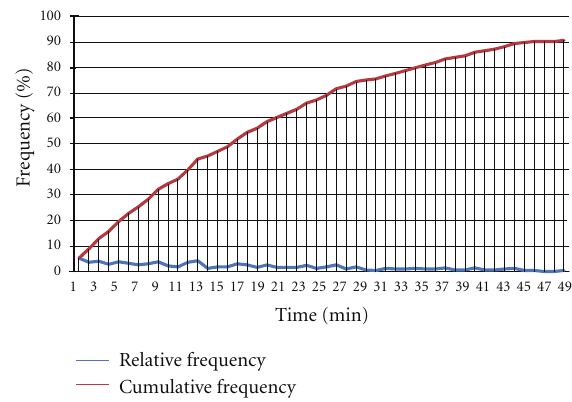
Figure 4: Frequency histogram of tagged events during MasterMed evaluation. Cumulative frequency graph shows that 40% of the events were tagged within the first 12